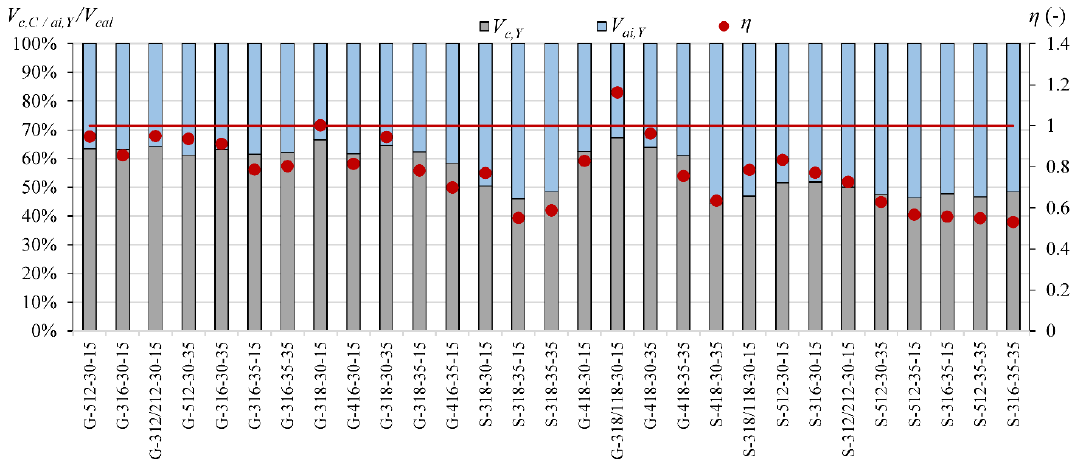
Figure 12. The shear capacity in rectangular beams for V c from Cladera et al.’s. and V ai from Yang’s models (red line indicated η = 1).